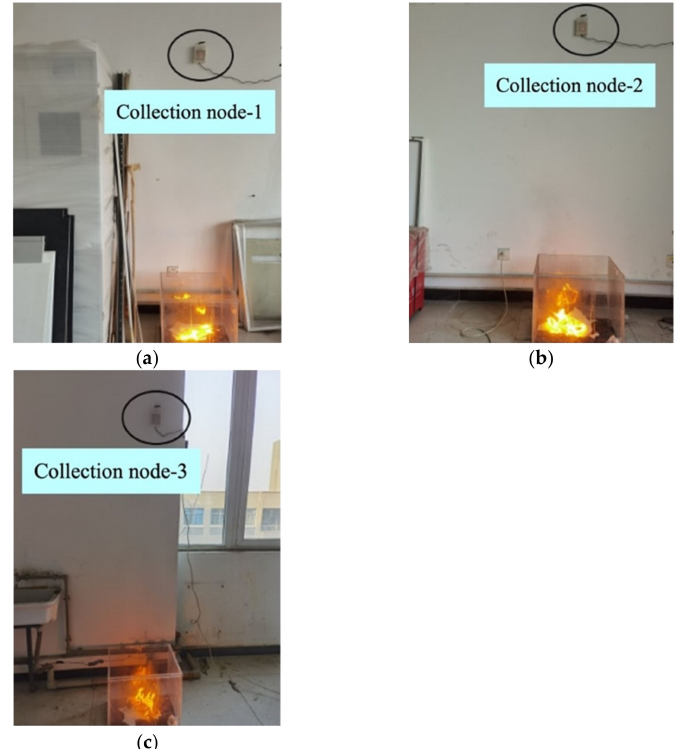
Figure 17. Distributed networking experiments: ( a ) Node 1; ( b ) Node 2; ( c ) Node